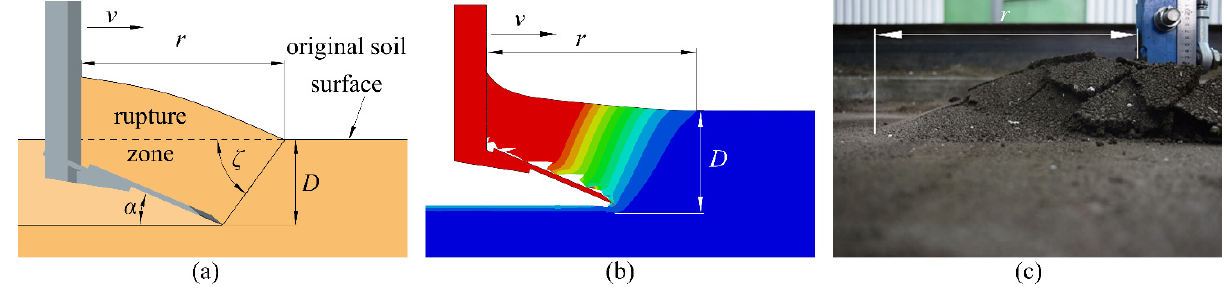
Figure 5. Diagram ( a ) of soil failure pattern and the phenomena in simulations ( b ) and soil bin experiments ( c ). r refers to the soil rupture distance, D refers to the working depth, ζ refers to the soil rupture angle, and α refers to the rake angle. Table 2. Factors and levels used in the simulations based on Box–Behnken